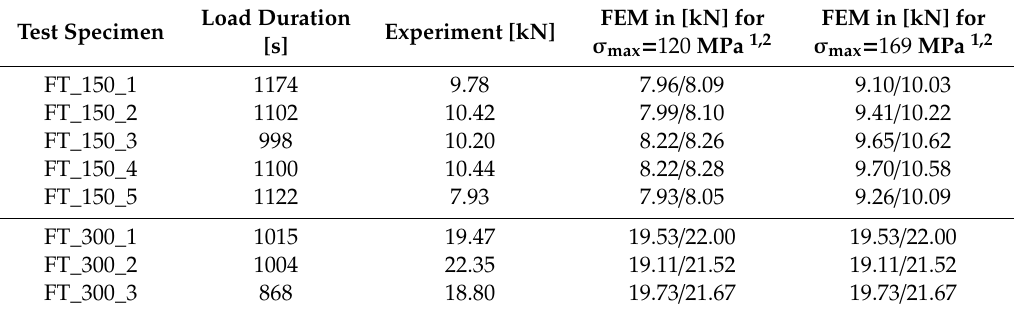
Table 5. Comparison of ultimate loads from experiments and numerical simulations for FT-glass.